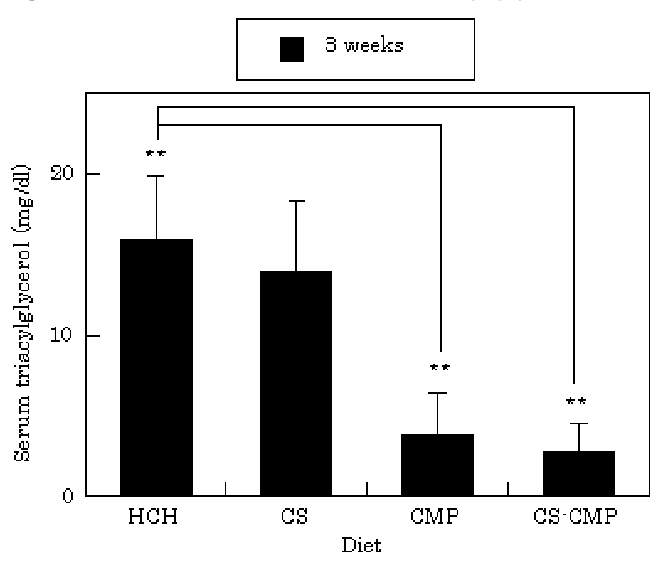
Figure 3. Effects of diet on serum triacylglycerol levels.